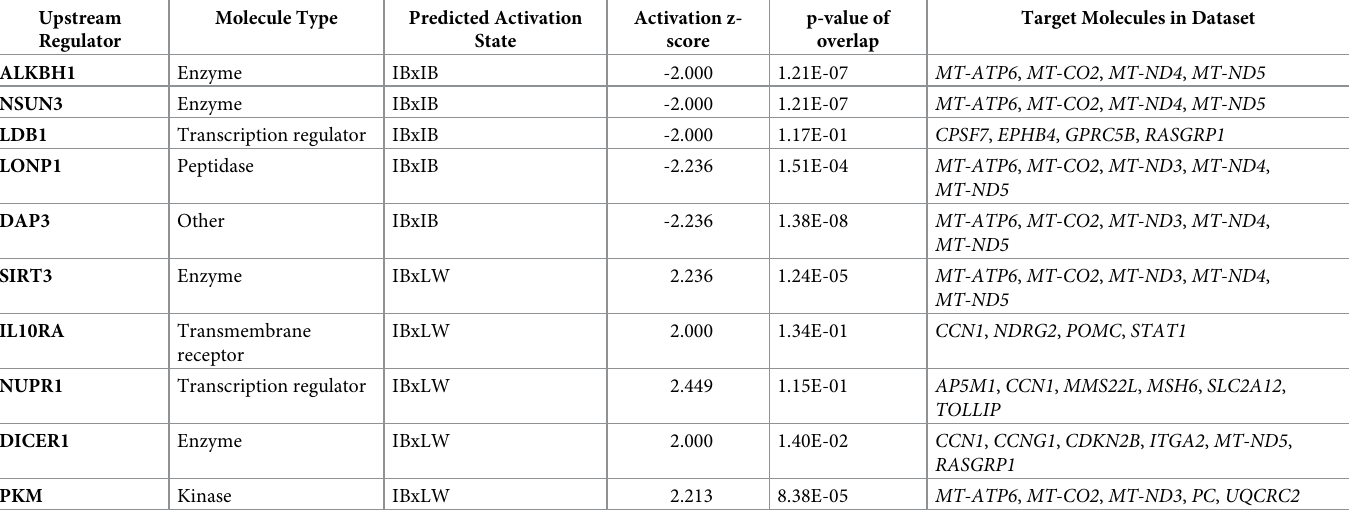
Table 7. Regulators predicted by IPA to be activated in 60 days-old pure Iberians (IBxIB; negative z-score) and in Iberian x Large White crossbred pigs (IBxLW; positive z-score). These regulators potentially control the differences in the hypothalamic transcriptome observed in males. Upstream Regulator